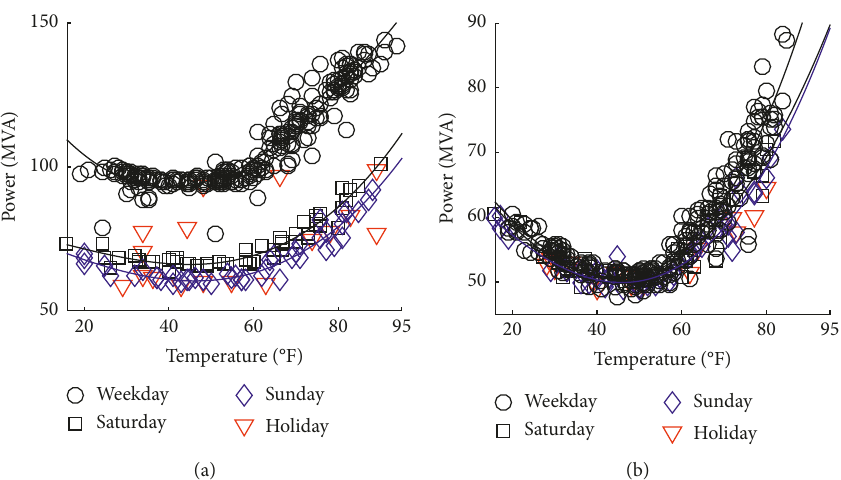
Figure 6: Power-temperature relation of one substation in 2010: (a) power-temperature relation at 11 AM; (b) power-temperature relation at 2